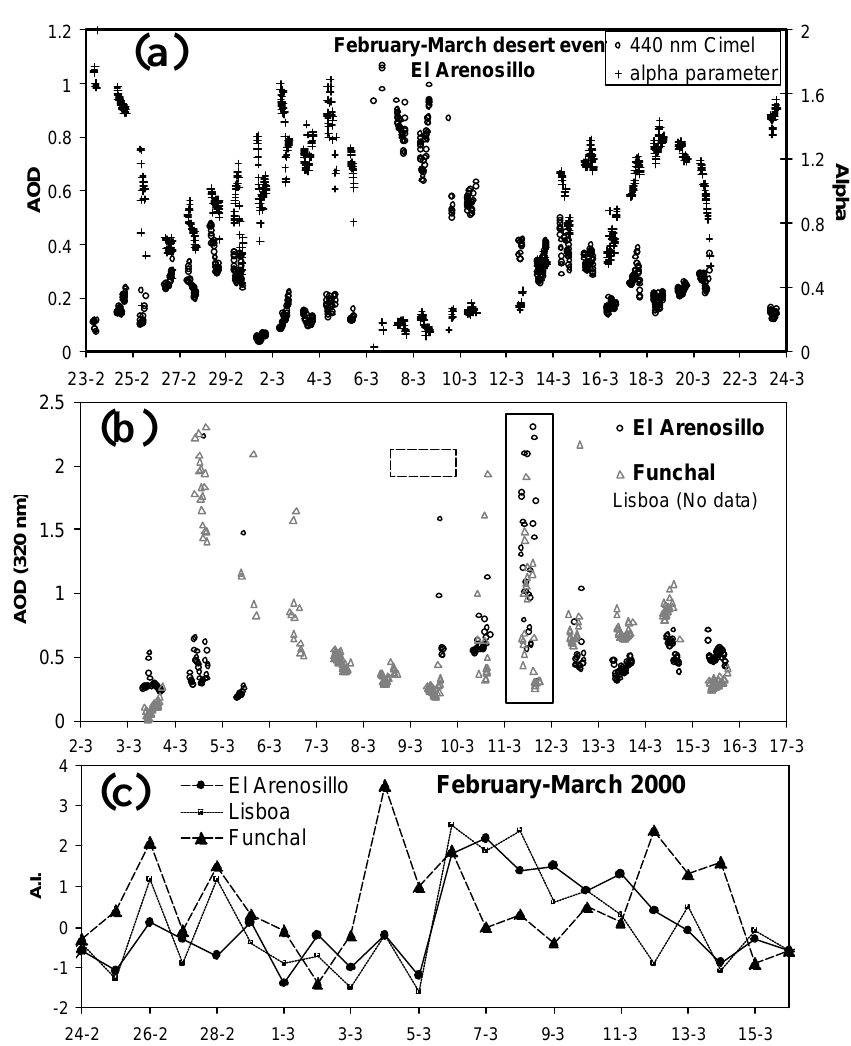
Fig. 5. AOD at 440nm and α evolution at El Arenosillo station for the February–March desert dust event. (b) AOD Brewer data at 320nm for the same event at the three stations. (c) same as b) but for A.I.